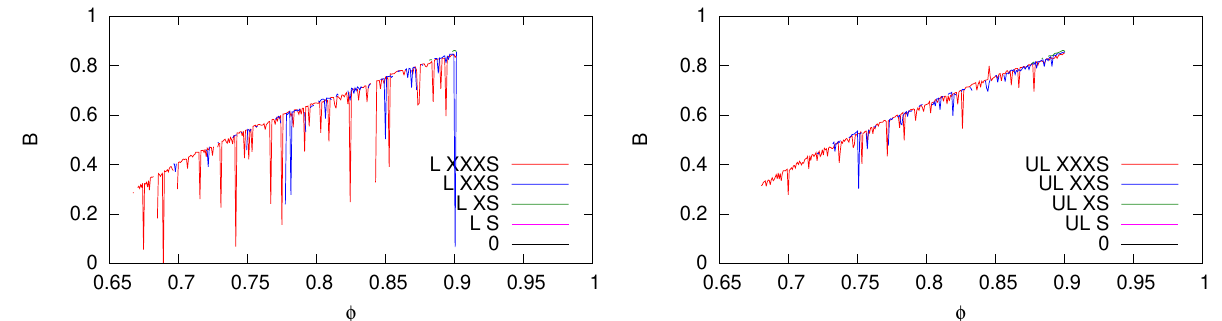
Figure 4. Bulk modulus, B = d p / d ε V , plotted (only for E k / E p < E 0 ) against volume fraction, from the same simulations as in Fig. 1, with same colors / symbols. Due to the rather low threshold E 0 , the faster simulations (S and XS) do not show up here, see Fig. 2. Due to the discrete di ff erentiation, the vertical peaks do not indicate B but the beginning / ending of a plastic, reorganization event with considerable dynamics.